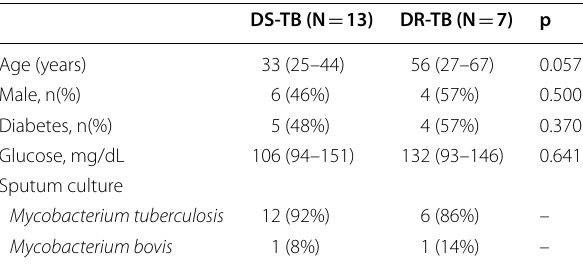
population before the use of anti‑TB